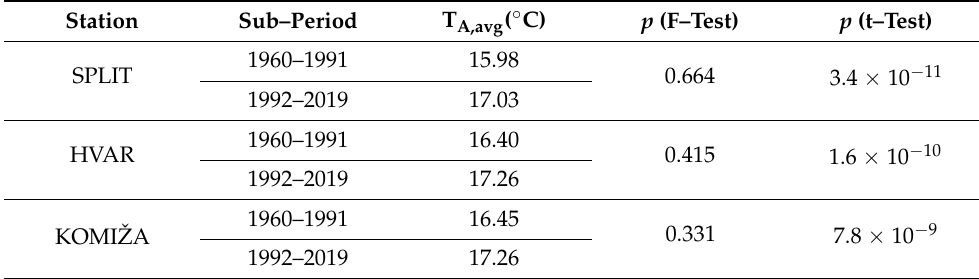
Table 4. The average values of the mean annual air temperature time series within a sub–period defined by the RAPS method at the analyzed stations and the results of the F–test and the t–test.